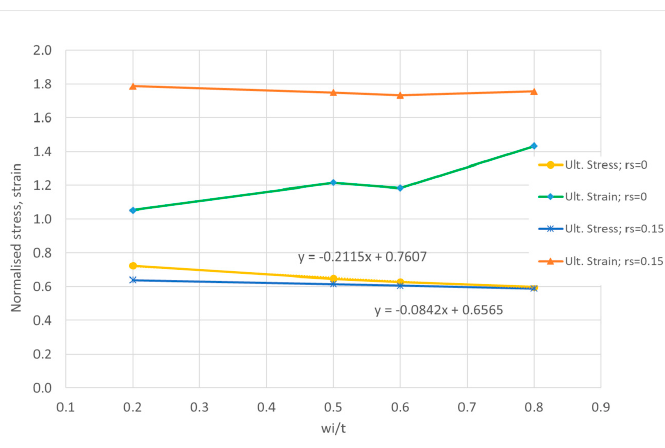
Figure 11. Variation of ultimate strength and corresponding normalized strain for plates with t = 10 mm, m = 3 and no residual stresses. Figure 10. Load shortening curves for intermediate plates ( β = 2.03) with different initial imperfections in critical mode and residual stresses.